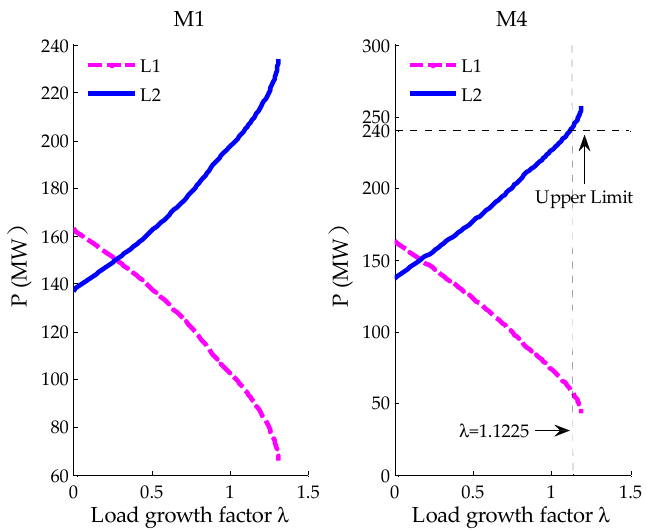
Figure 8. Curves of active power transmitted in tie-lines under schemes M1 and M4.